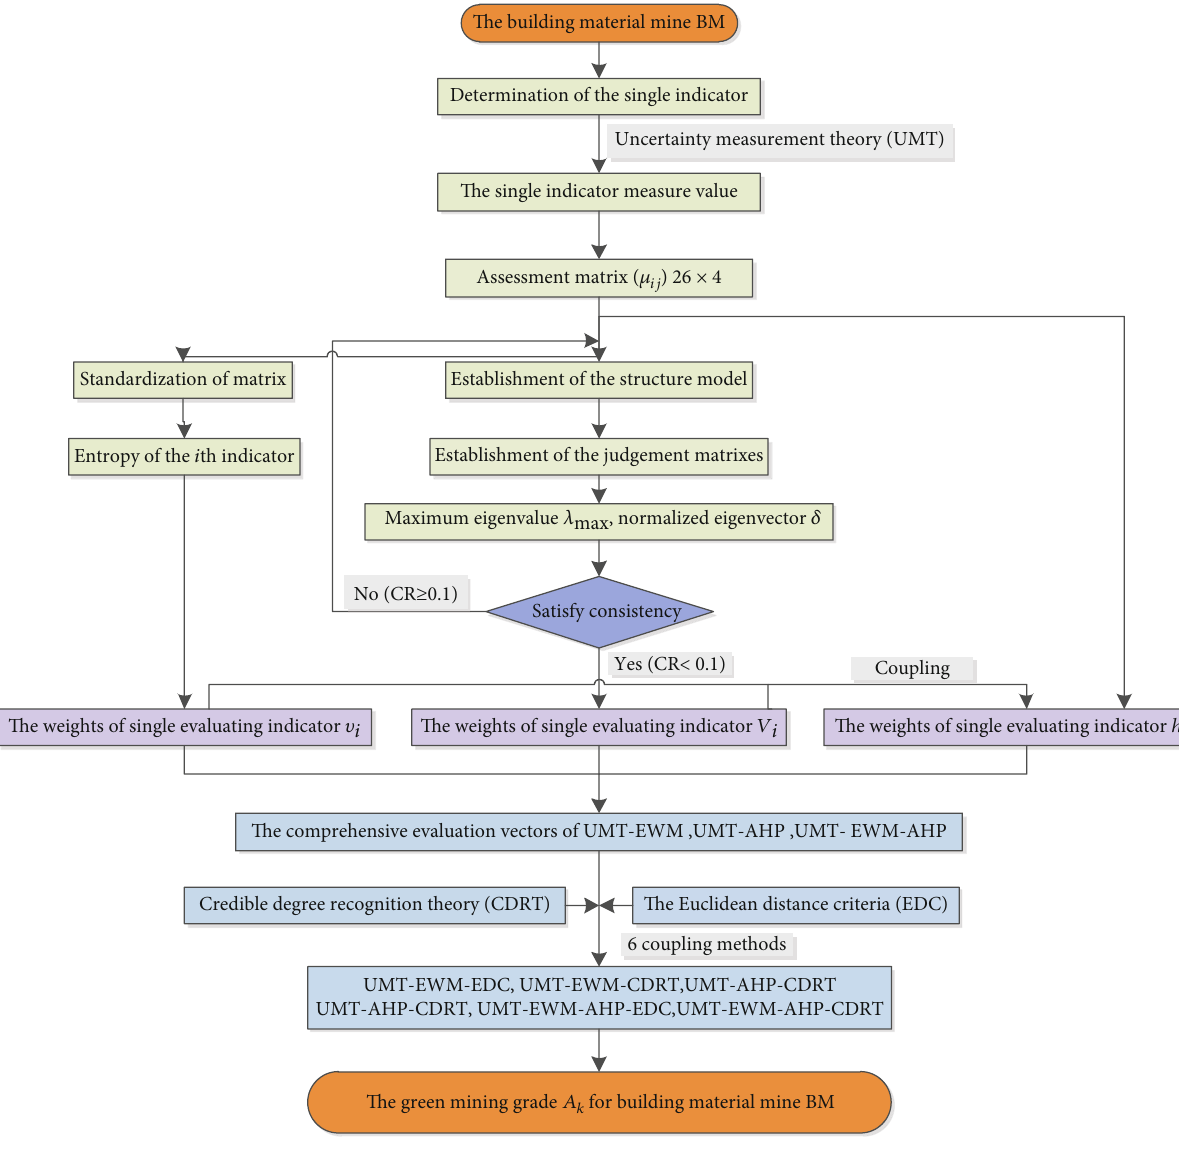
Figure 2: Flowchart for evaluating GM grade A